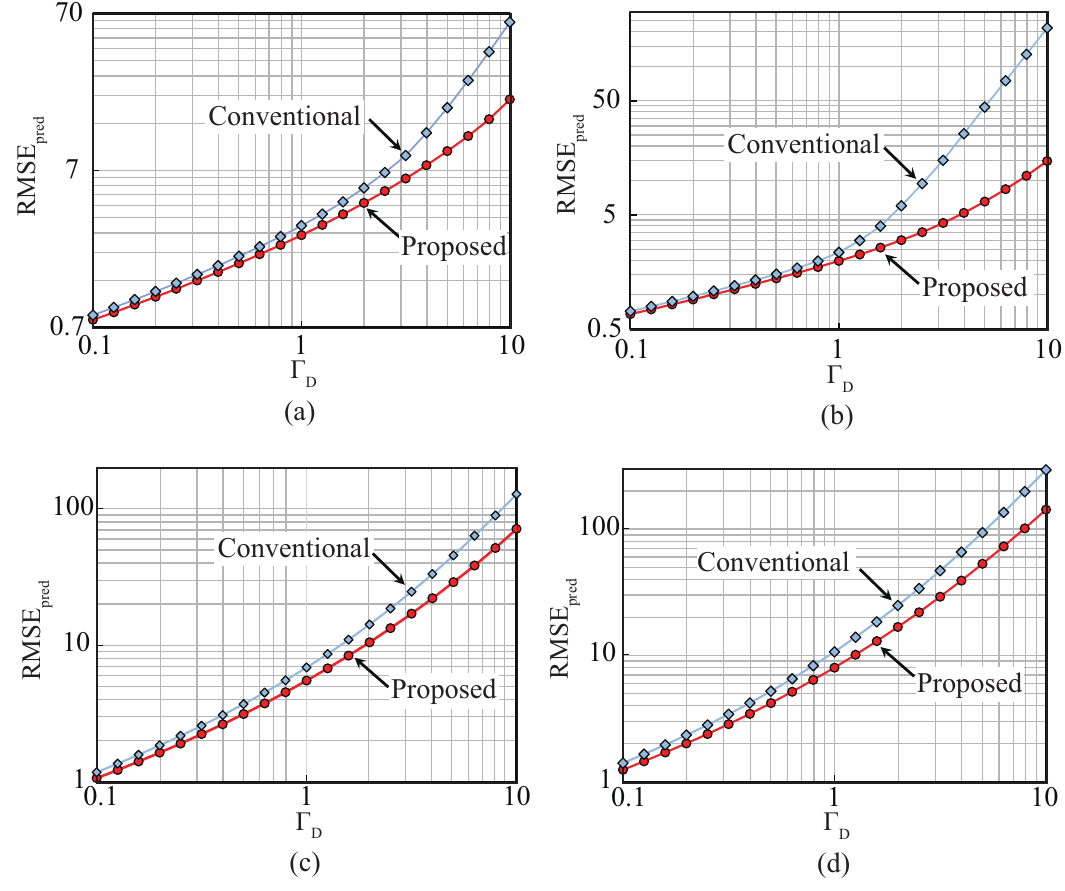
Figure 1. Relationship between Γ D and RMSE pred for c RD = 0.25 ( a ); 0.5 ( b ); − 0.25 ( c ); and − 0.5 ( d